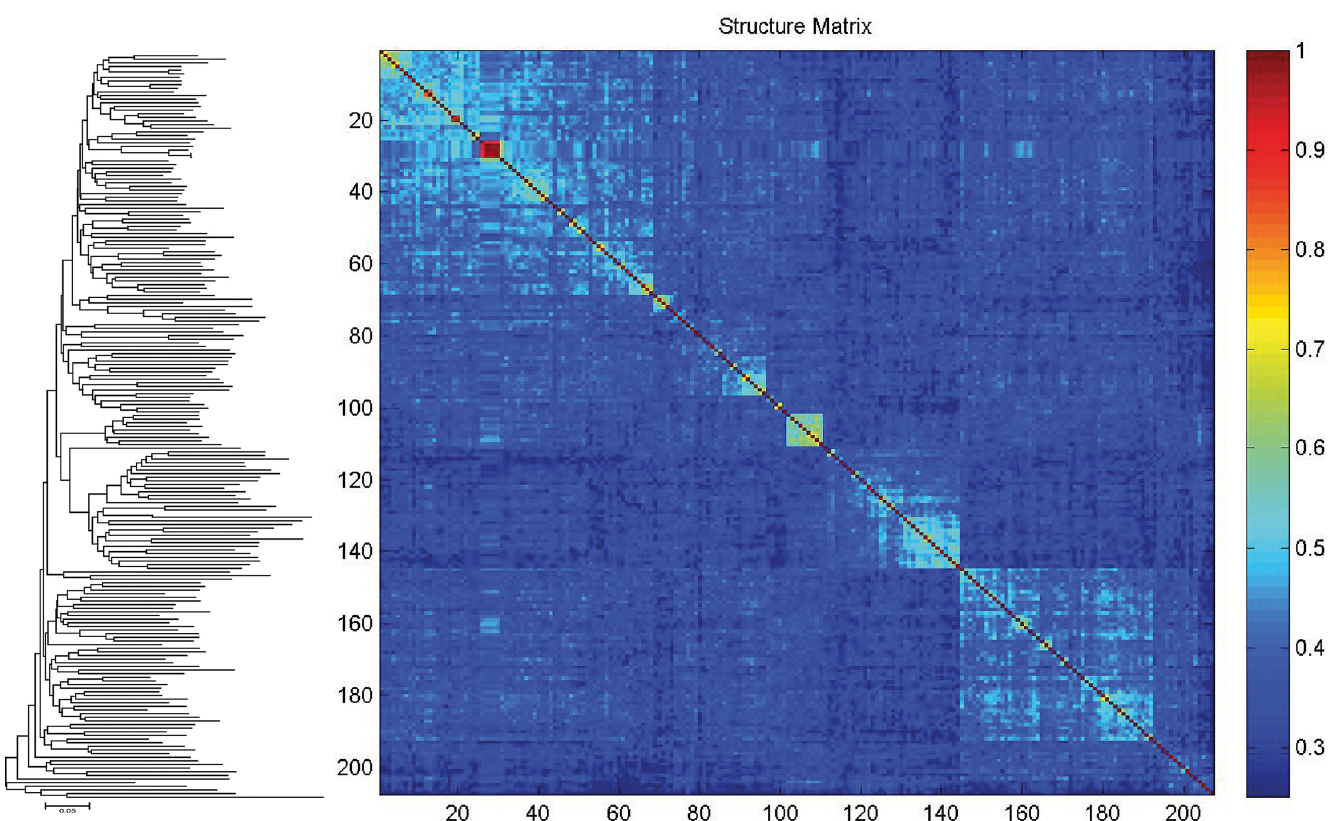
Fig 5. Klee diagram of the analyzed crustacean species. The image was generated from a TreeParser-ordered alignment with a correlation scale presented at the right of the diagram. Sequence clusters appear as blocks of higher correlation along the diagonal, on the left a corresponding NJ topology in identical order (see S3 Fig for